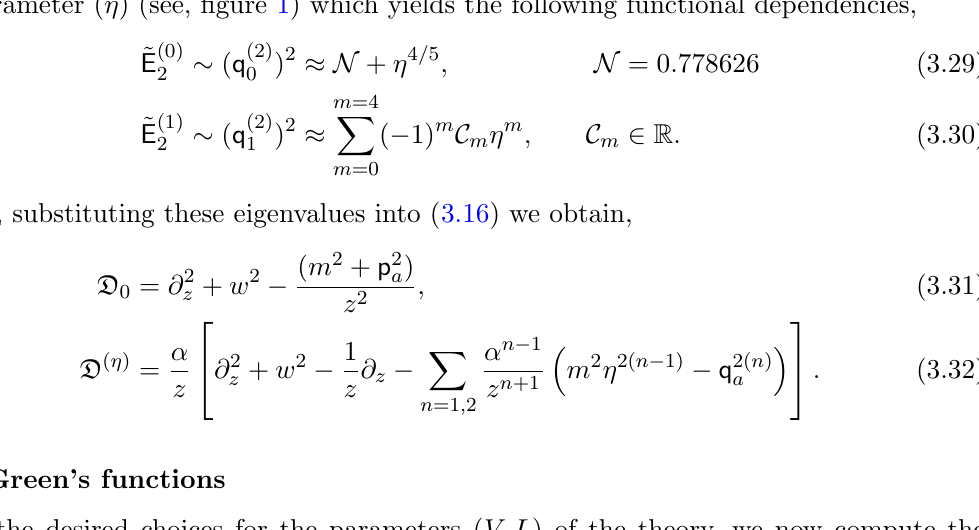
Figure 1 . Energy eigenvalue spectrum with V = 3 and L = (cid:25) eigenvalues ( q (2) ) 2 and the red curve corresponds to eigenvalues ( q (2) 1